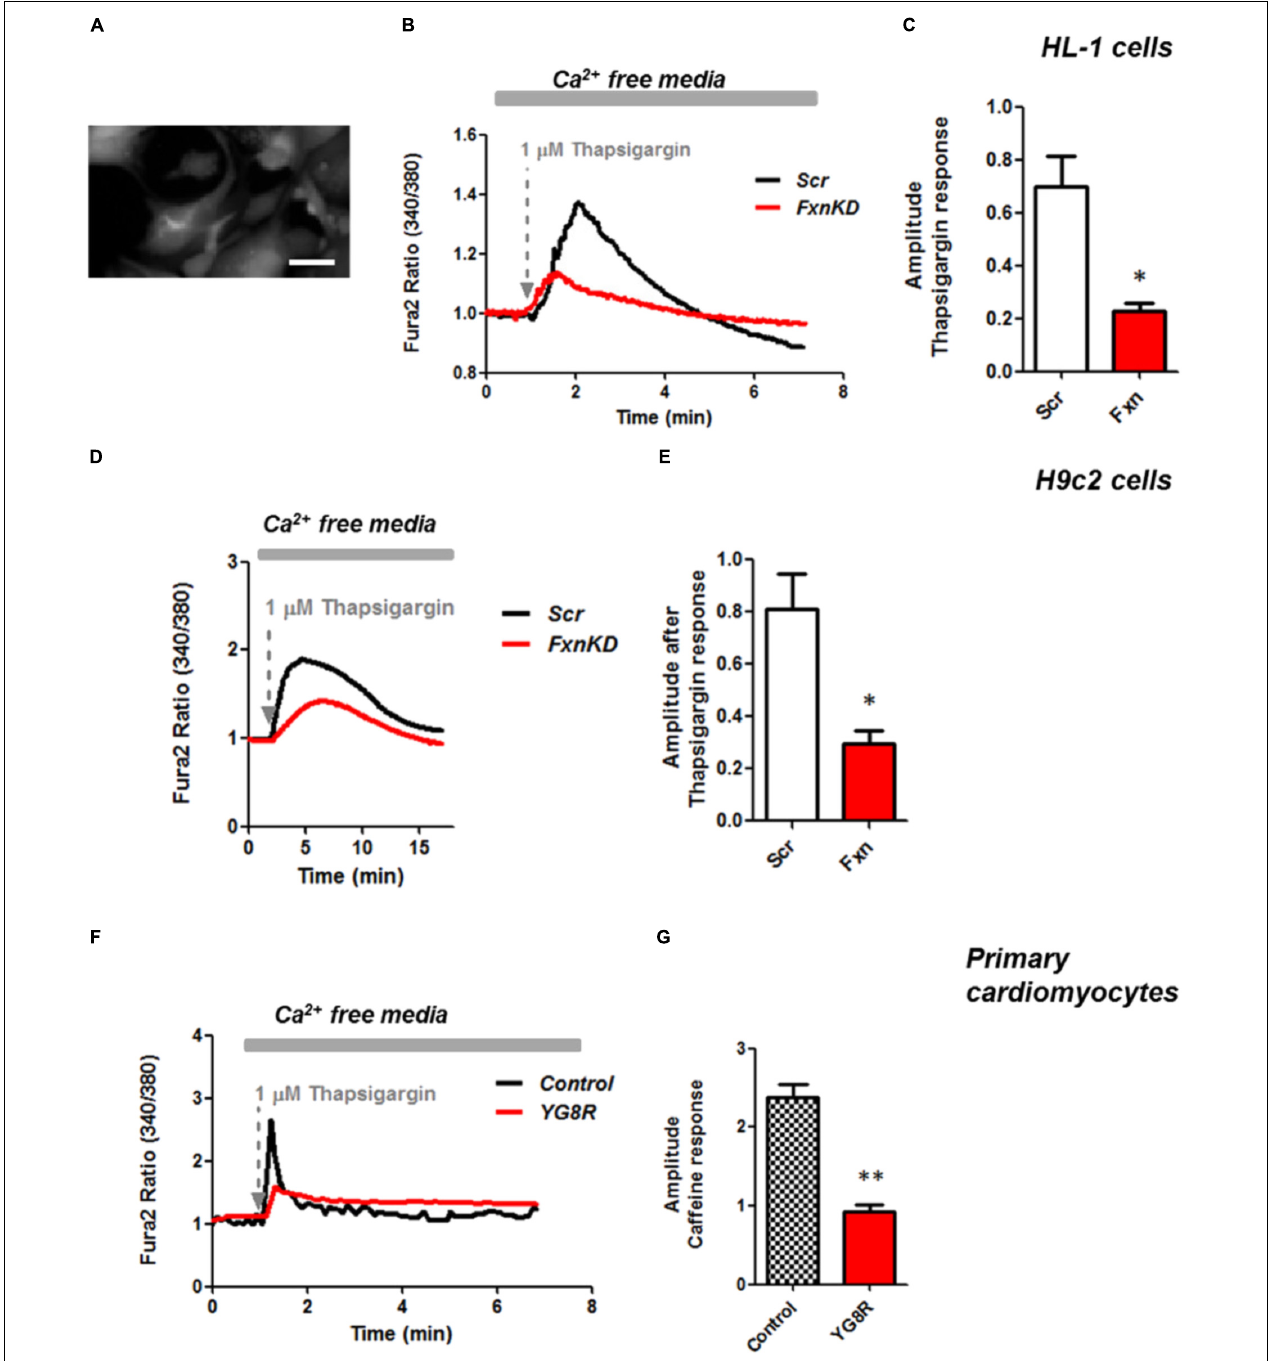
FIGURE 5 | Frataxin silencing causes SR Ca 2 + store depletion in cardiomyocytes. (A) Loading of Fura2-AM. (B,D,F) FxnKD cells show a marked difference to 1 µ M thapsigargin response compared to Scr. (C–G) The amplitude of the response in relative values % shows a significant decrease in FxnKD cells which reveals a decrease of Ca 2 + content in the SR ( ∗ p < 0.05; ∗∗ p < 0.005). Scale bar (20